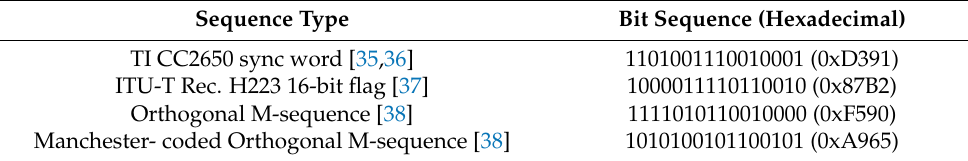
Table 6. SFD used in computer simulations.